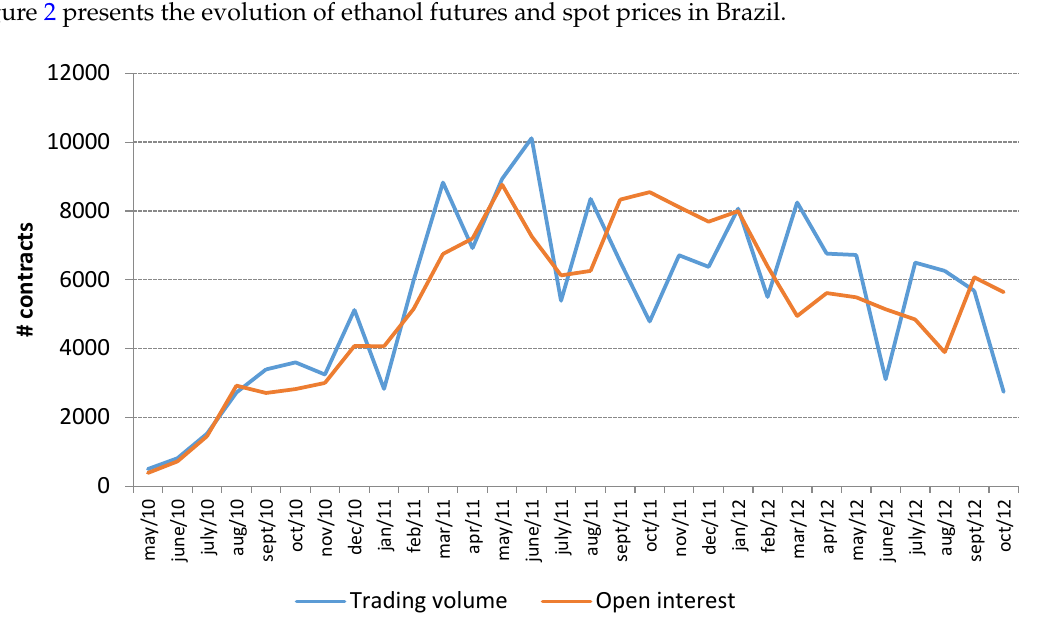
Figure 1. Monthly trading volume and open interest of ethanol in BM&F-BOVESPA.